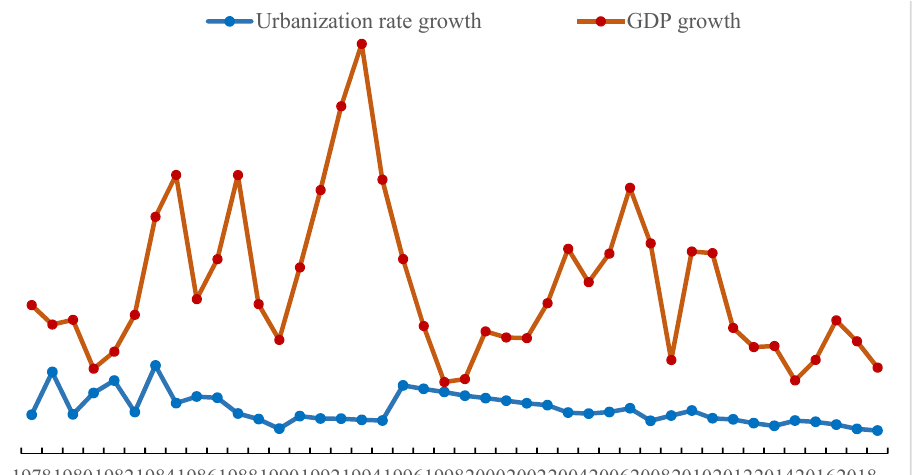
Figure 6. China’s population, urbanization rate, and GDP growth rate changes since the Reform and Opening up (data source: China Statistical Yearbook).